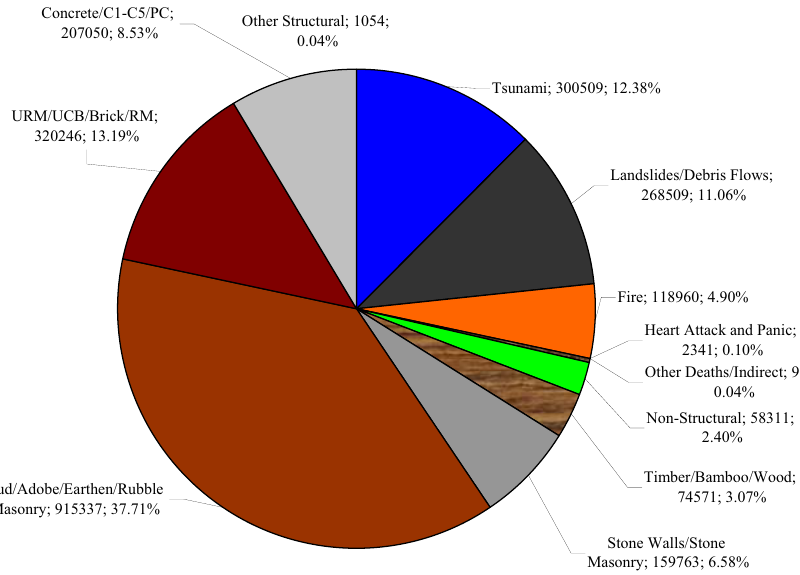
Fig. 12. Shaking and Secondary Effect Deaths Worldwide for 1996 fatal earthquakes (Daniell et al., 2010c, Daniell, 2010a).